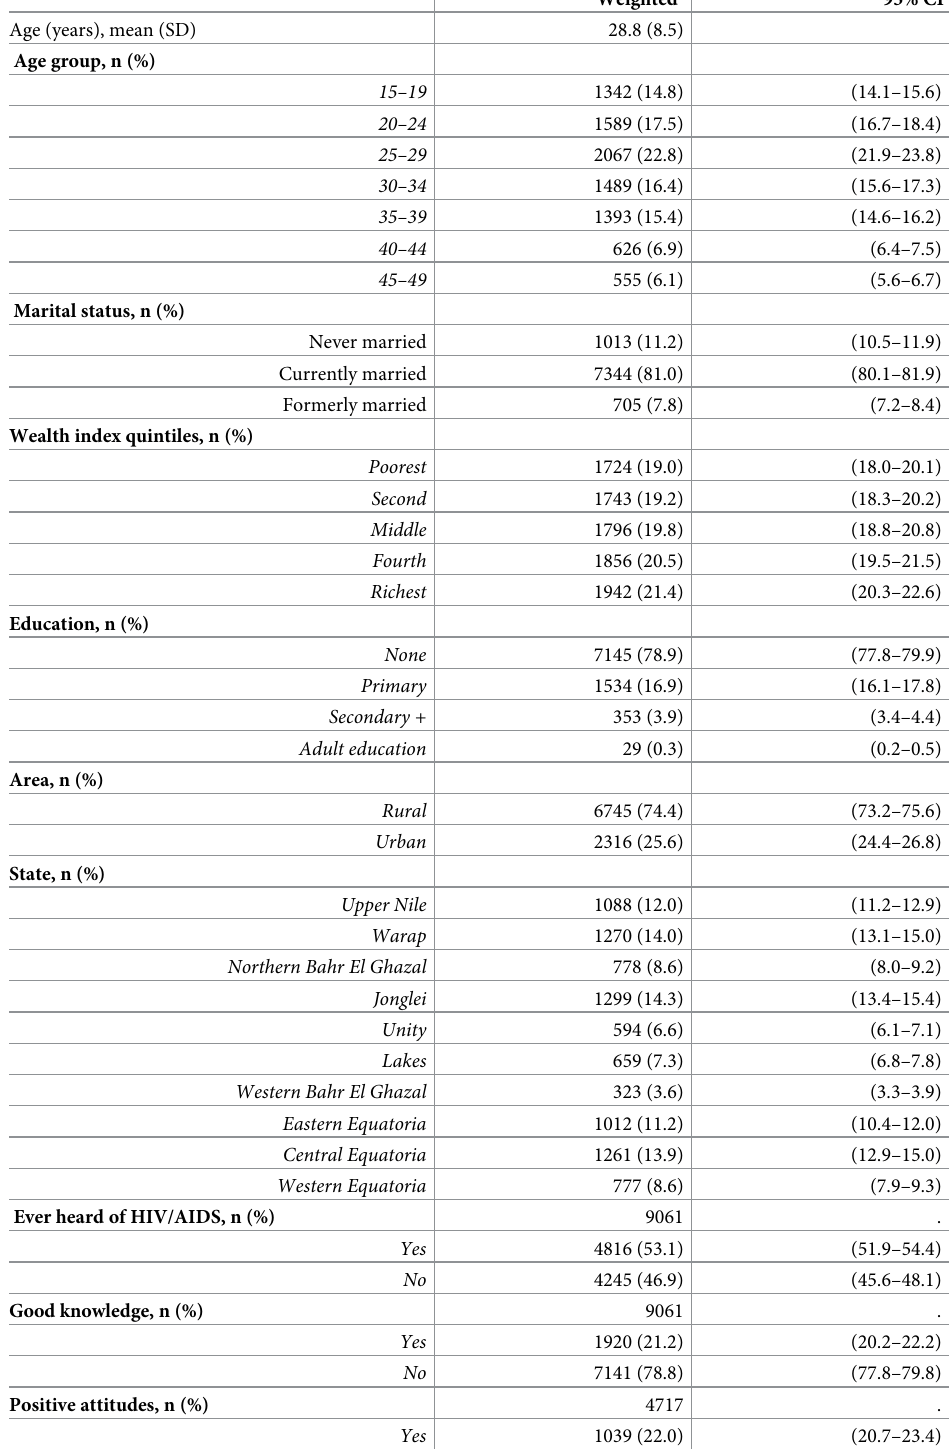
Table 1. Characteristics of South Sudanese women aged 15–49 years old relating to HIV knowledge (n = 9061) and attitudes (n = 4717) towards people with